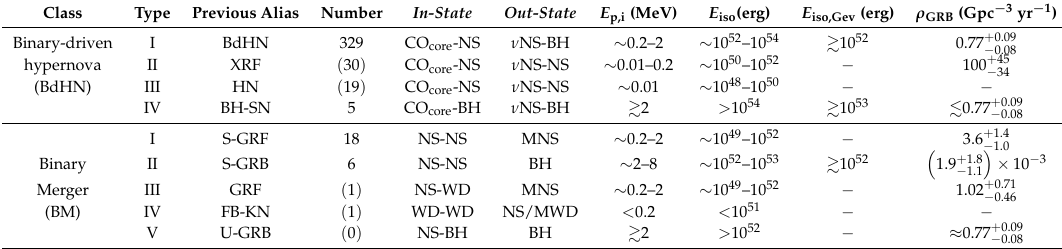
Table 1. Summary of the Gamma-ray bursts (GRB) subclasses. This table is an extended version of the one presented in [49] with the addition of a column showing the local density rate, and it also updates the one in [45,47]. We unify here all the GRB subclasses under two general names, BdHNe and BMs. Two new GRB subclasses are introduced; BdHN Type III and BM Type IV. In